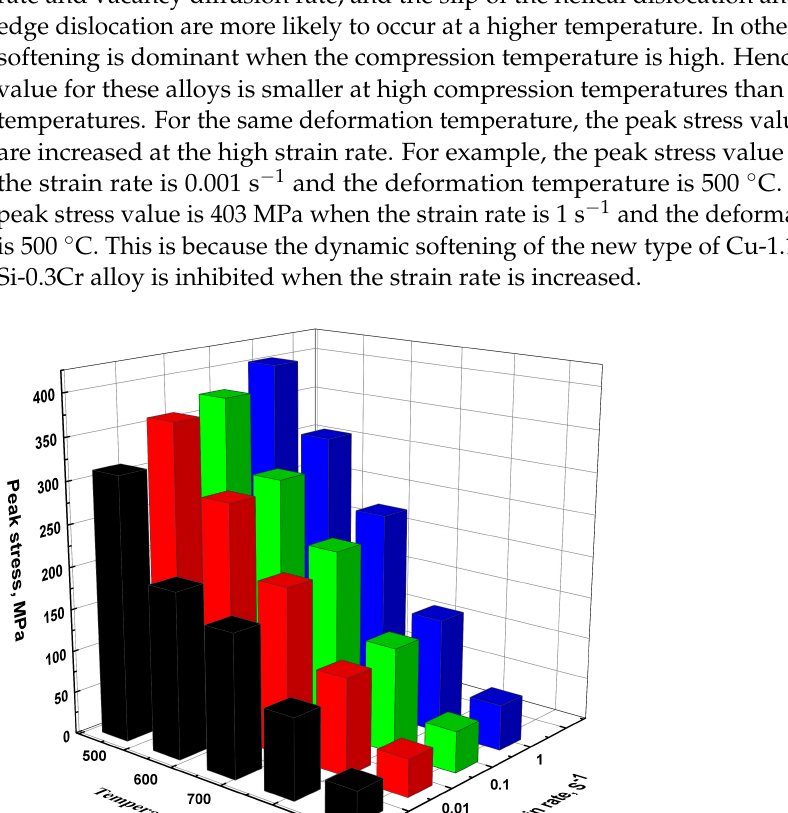
Figure 2. Peak stress of the new type of Cu-1.1–Ni-0.7–Co-0.45–Si-0.3Cr alloy at different compression temperatures and strain rates.